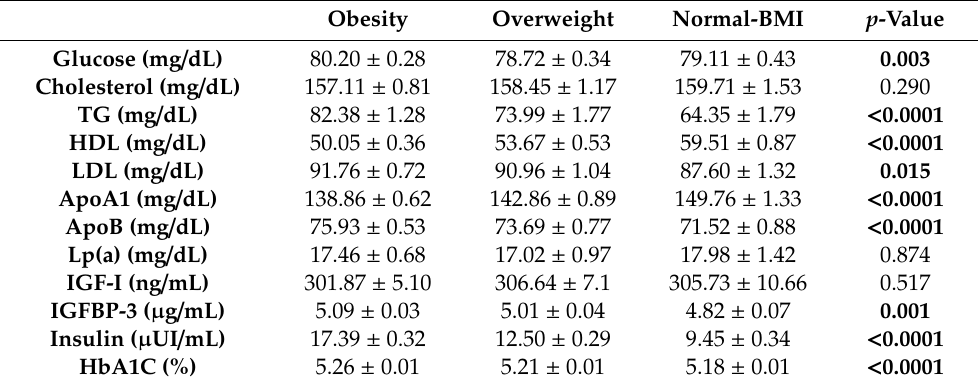
Table 3. Biochemical and endocrinologic parameters in all subjects at baseline.